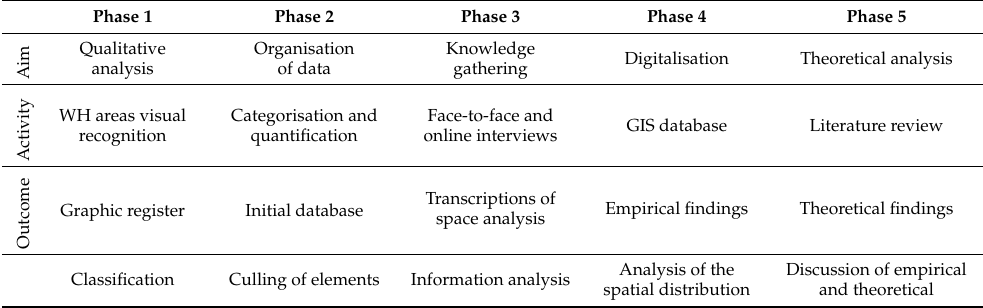
Table 1. Design of the research for the registration and characterisation of unconventional